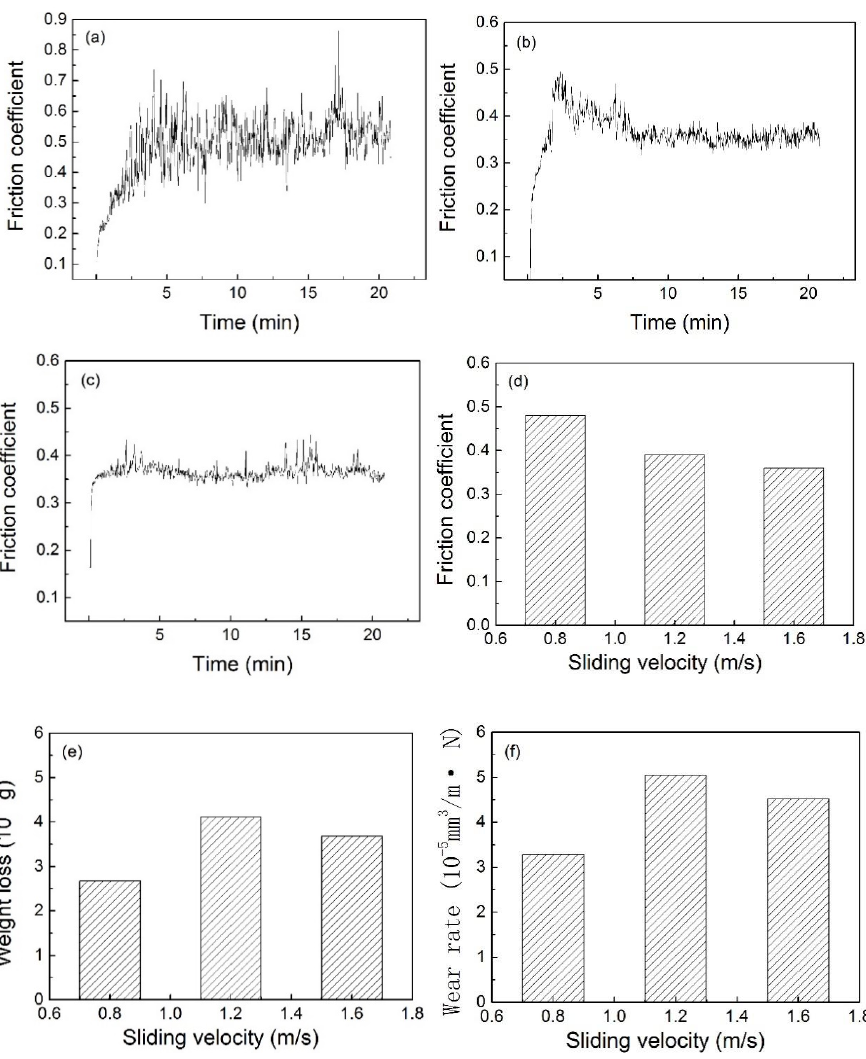
Figure 11. Friction coefficient, weight loss and wear rate of the rheoformed composite parts at different sliding velocity: ( a ) friction coefficient at 0.8 m/s, ( b ) friction coefficient at 1.2 m/s, ( c ) friction coefficient at 1.6 m/s, ( d ) average friction coefficient, ( e ) weight loss and ( f ) wear rate.